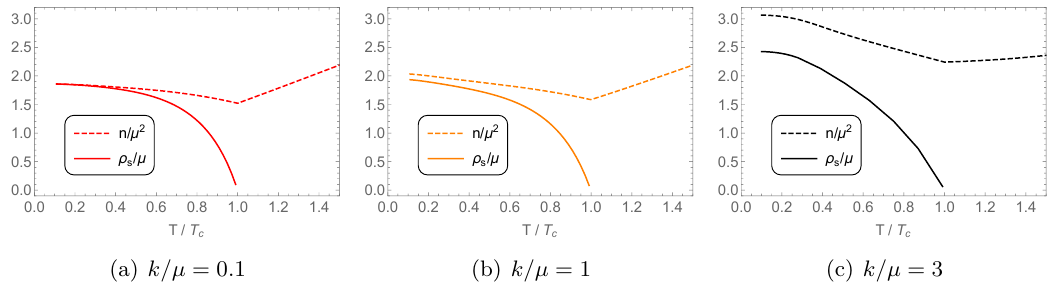
Figure 5 . The charge density n , superfluid density ρ s vs T/T c . The gap between n and ρ s at √ T = 0 opens at finite k/µ ( τ = 1 / 3 ).